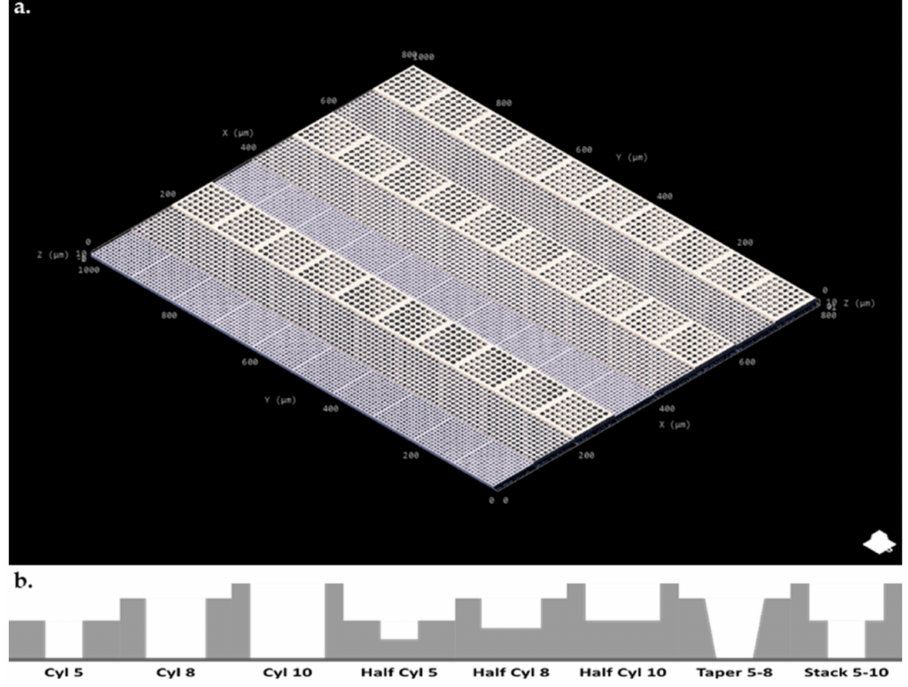
Figure 1. ( a ). AutoCAD Nanoscribe cell array design ( b ). Cross sectional diagram of individual wells seen in each block